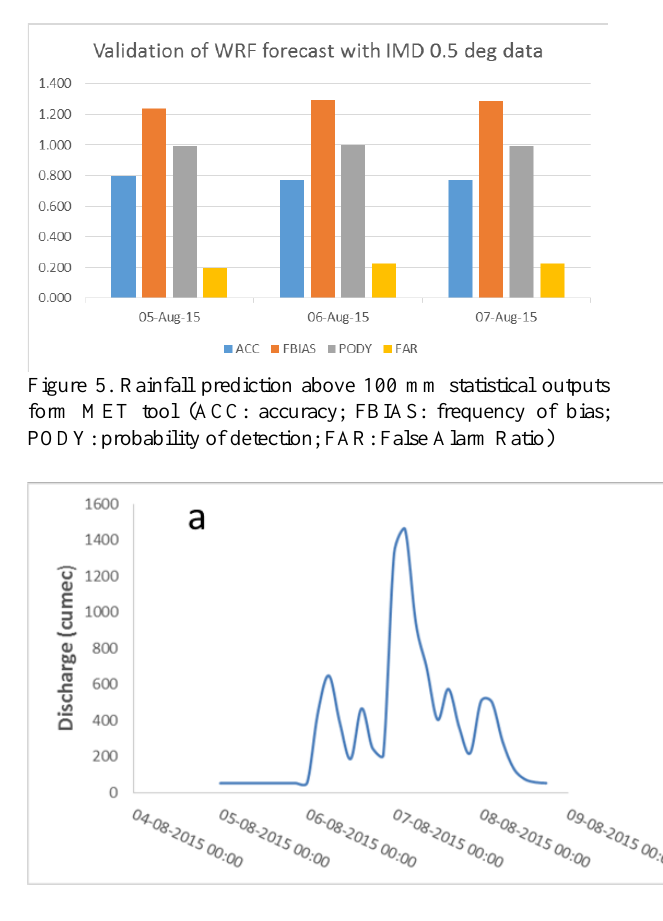
Figure 4. Forecasted rainfall on dated Aug 05, 2015 for Aug 05- 08, 2018, showing very heavy rainfall in Mandi district, HP